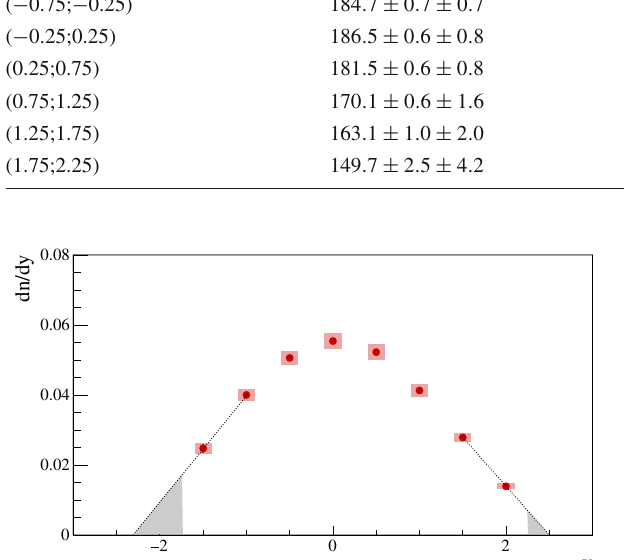
Fig. 11 Rapidity distribution dn / dy of K 0 mesons in inelastic p+p S interactions at 158 GeV / c . Solid red-coloured circles correspond to the NA61/SHINE results (systematic uncertainties not shown on the plot), open circles are mirrored values, black squares represent results from Brick et al. at FNAL [11] and blue full diamonds show results obtained ( N + 3 · N ) using charged kaon yields recently from the formula 1 K + K − 4 mesons. The numerical measured by NA61/SHINE at the same beam momentum [5] S